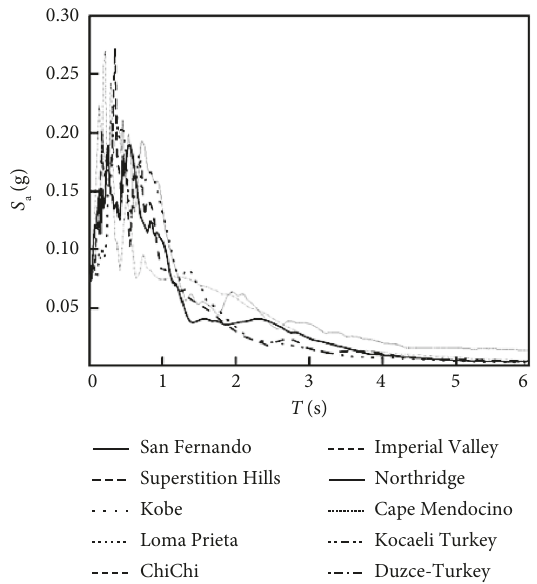
Figure 11: Seismic wave acceleration response